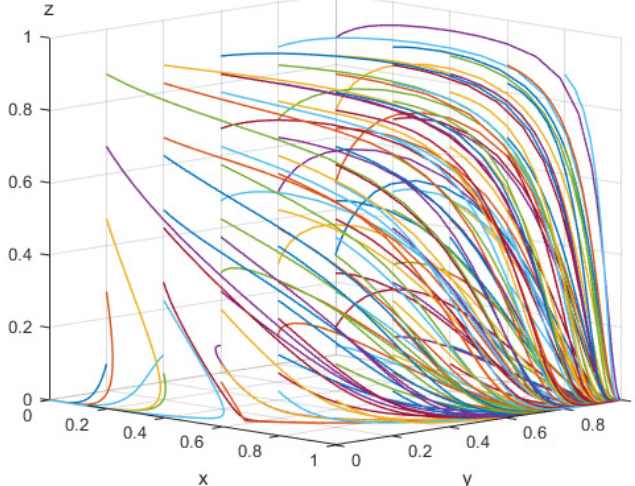
Figure 3. The result of 50 evolutions by initial values.